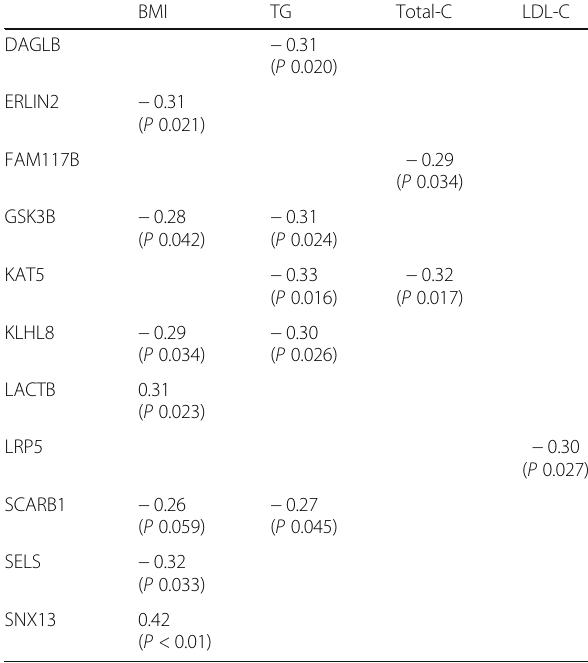
Table 6 Correlations between subject characteristics and differentially expressed genes associated with plasma n-6 level and/or SFA to PUFA ratio (n